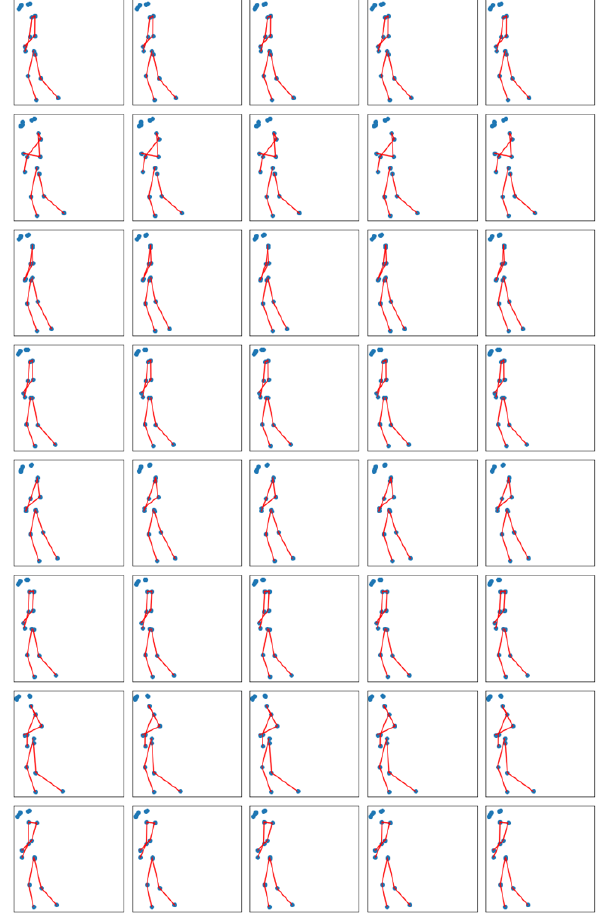
Figure 11. Selected generated poses for Class